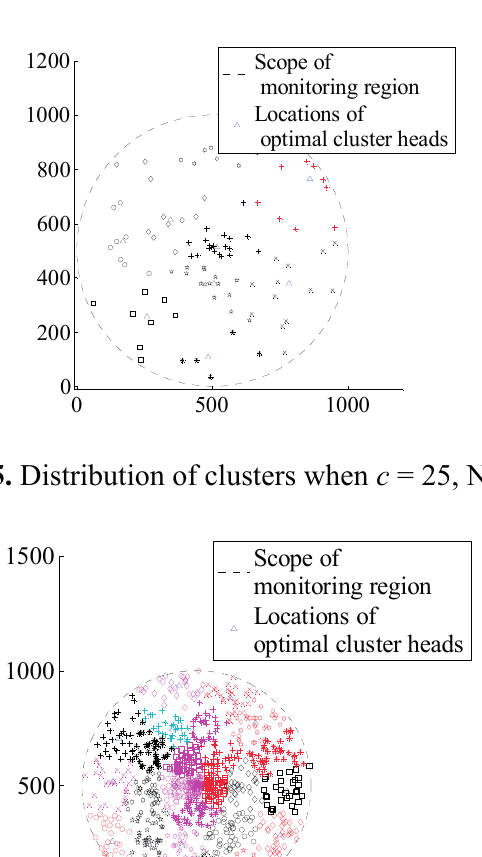
Figure 4. Distribution of clusters when c = 9, N = 100.